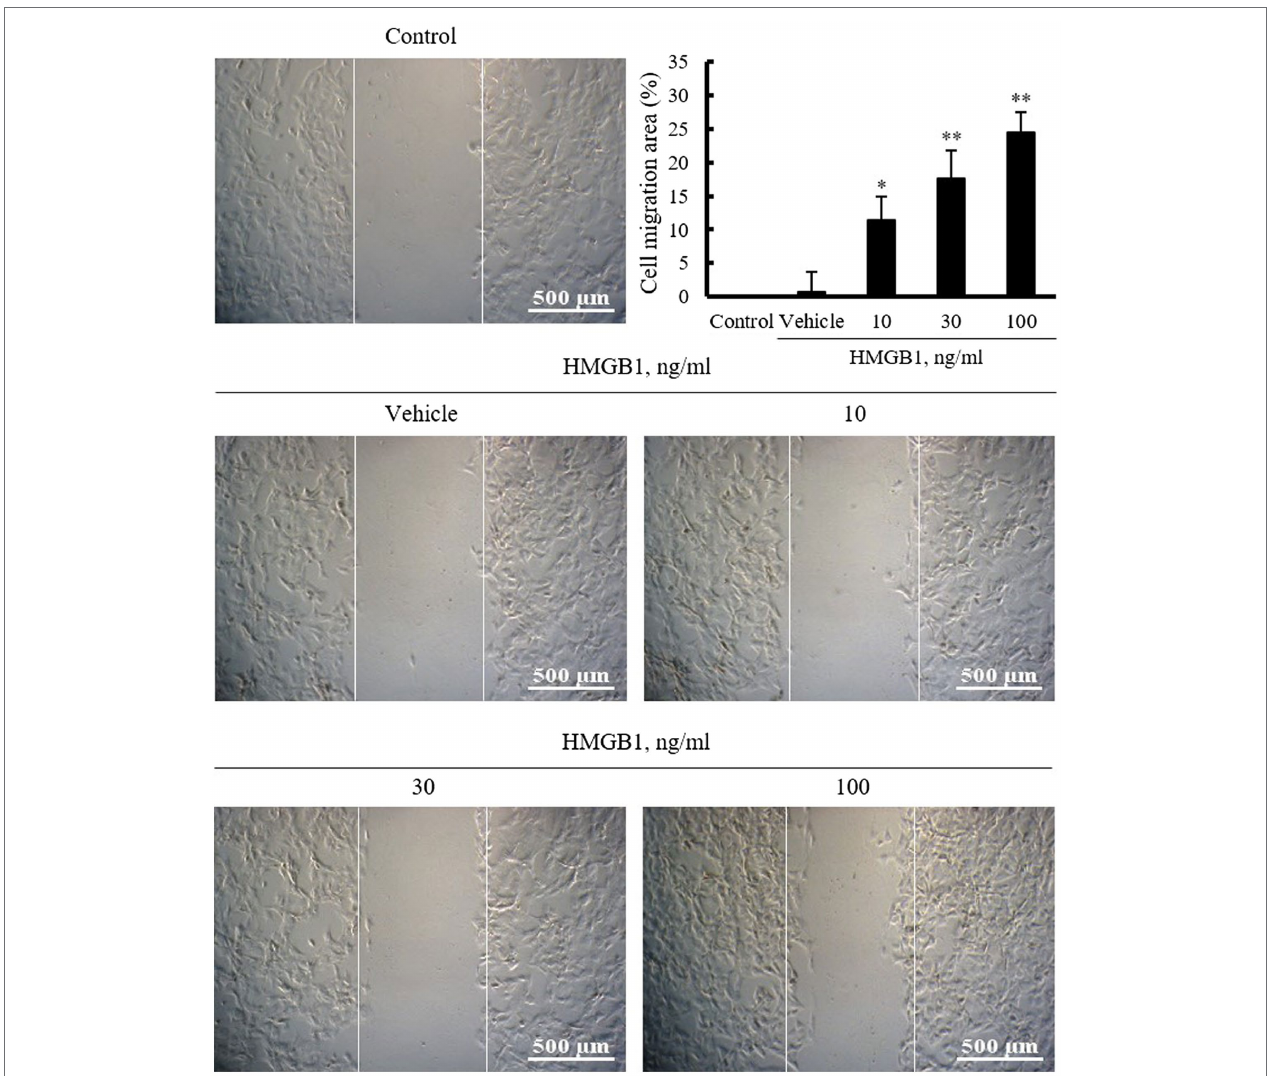
FIGURE 1 | The effects of HMGB1 on VSMC migration. Rat aortic VSMCs were treated with HMGB1 (10 to 100 ng/ml) for 48 h. Cell migration was determined by wound-healing assay. Representative photomicrographs of cell monolayers at 48 h post-wounding. Cell migration area (%) was calculated from the ratio of changes in wound area. Scale bar: 500 μ M. Data were quantified, expressed as the mean ± SEM of six independent experiments. * p < 0.05 and ** p < 0.01 vs. value in